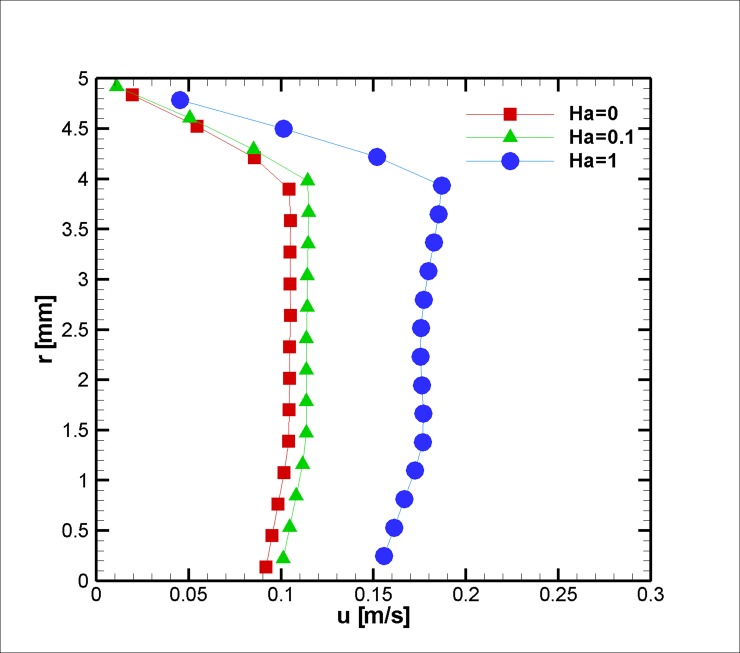
Velocity in the axial direction distribution for three different Ha Numbers at z = 2 cm and t = 0.5 s, Lvessel = 7 cm, Rvessel = 1 cm and a fifty percent stenosis.